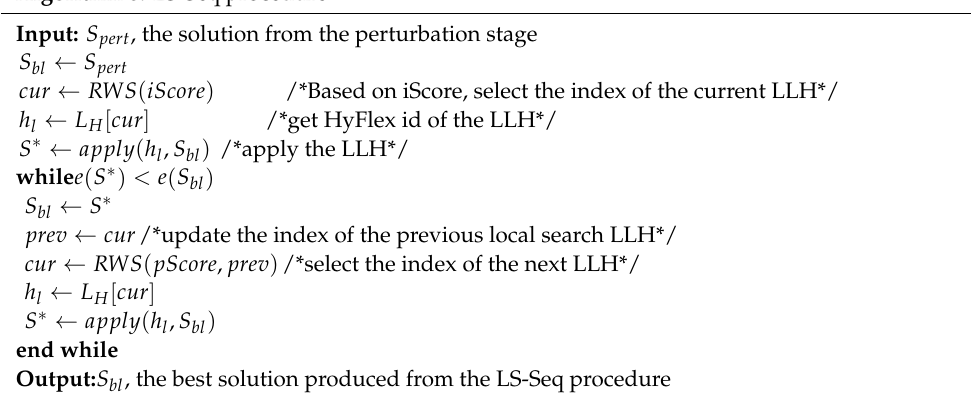
Algorithm 8: LS-Seq